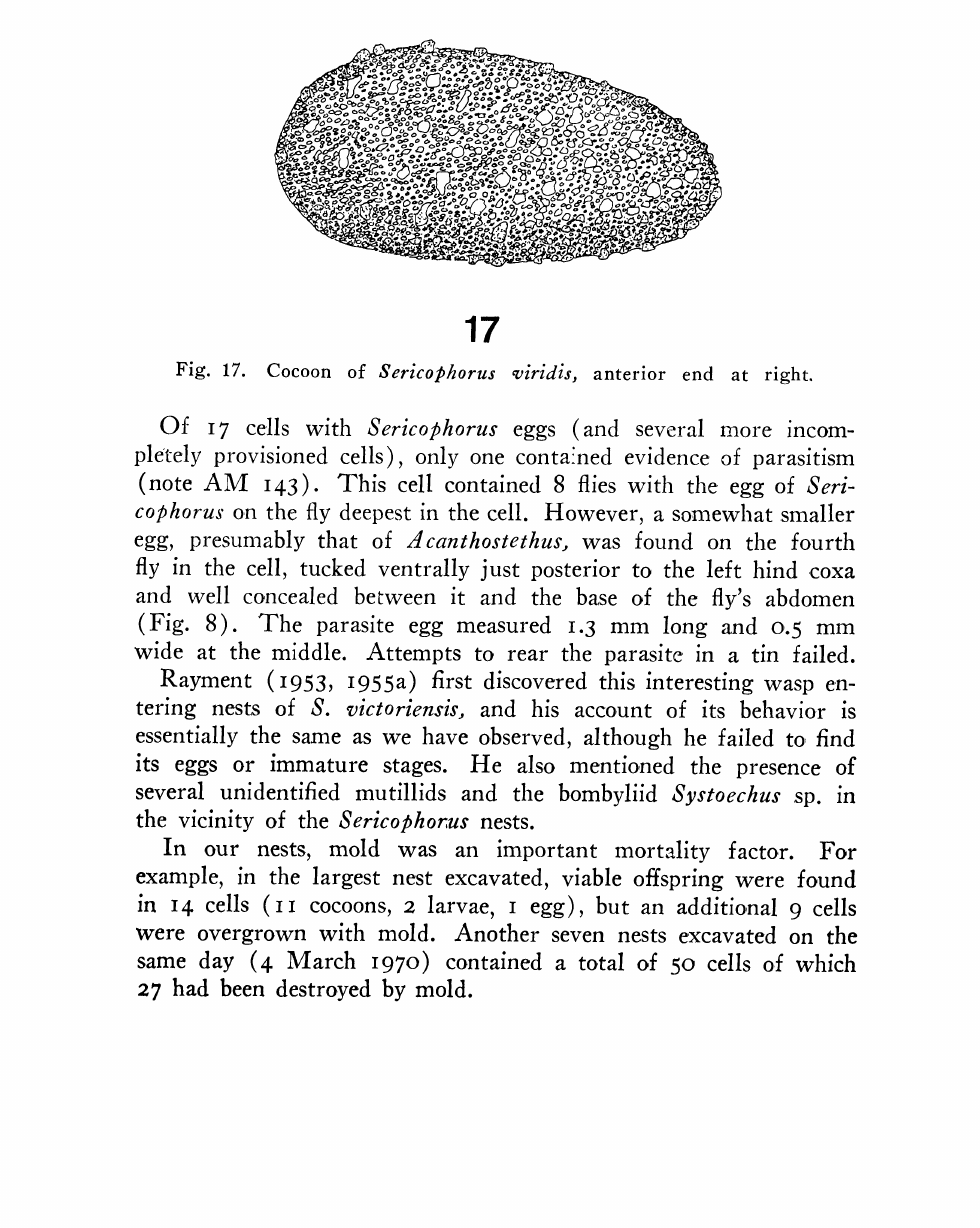
Fig. 17. Cocoon of Sericophorus eiridis, anterior end at